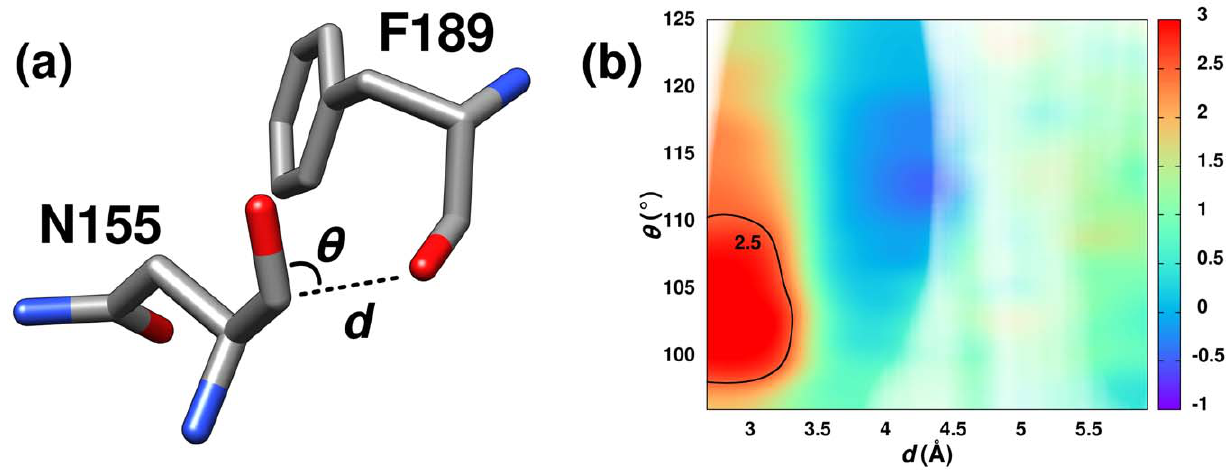
Figure 1. Predicted n { p (cid:1) Interaction and Associated Carbonyl 13 C Chemical Shifts. ( A ) Residues Asn155 and Phe189 from the x-ray structure of Bacillus amyloliquefaciens subtillisin BPN’ (PDB ID: 1v5i) illustrating the structural features for an optimal n { p (cid:1) interaction between carbonyl groups. ( B ) 2D contour plot of carbonyl 13 C chemical shift differences relative to random coil values as a function of the distance ( d ) and angle ( h ) between carbonyls. A Gaussian smoothing function was applied to the data with D x and D y of 0.3 A˚ and 1.5 u , respectively. A transparency mask based on the density of experimental data (see also Figure S1) is overlaid on the contour plot. Regions lacking experimental data are white. Positive values indicate downfield shifts.